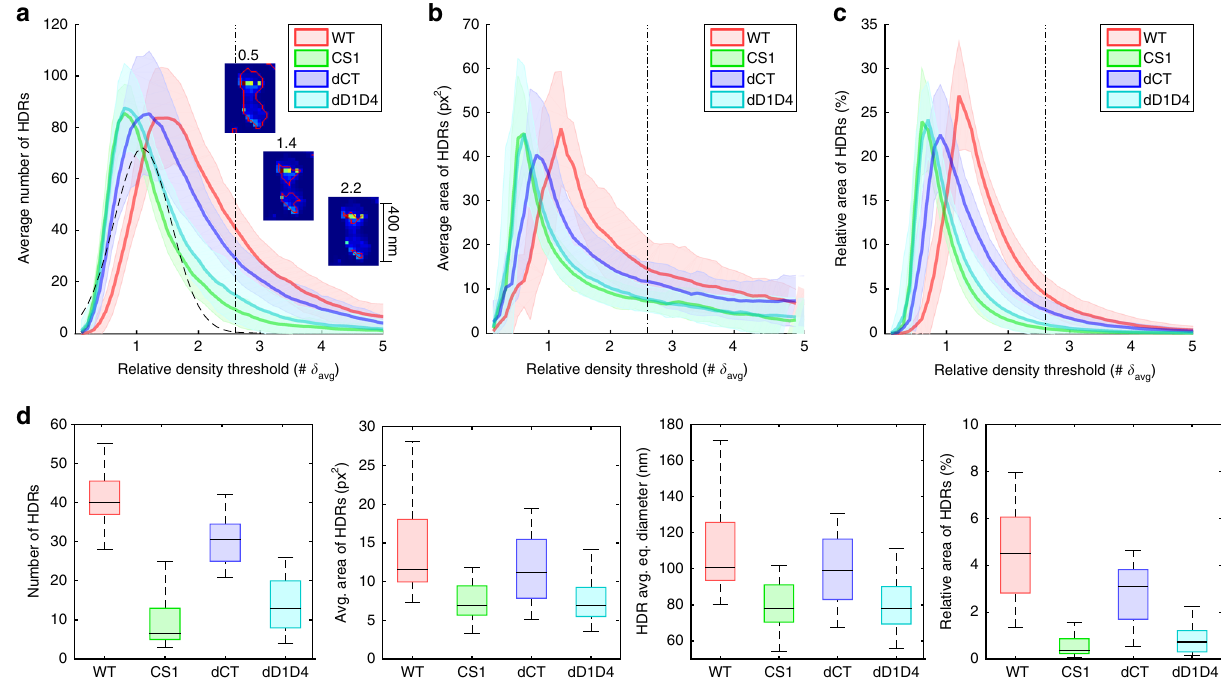
Fig. 3 SOFI analysis of four CD4 protein variants in resting T cells immobilized on poly- L -lysine-coated coverslips. Native CD4 (WT), palmitoylation mutant (CS1) and variants lacking the extracellular (dD1D4) and cytosolic parts (dCT) were tested ( n = 20 per variant). a Number of high-density regions (HDRs) averaged over all samples for each CD4 variant. Density thresholds are related to the mean density calculated over the 3 × 3 µ m ROIs of all samples. The inset images show examples of the segmented HDRs for various thresholds indicated above the image. b HDR area averaged over all samples for each CD4 variant in px 2 , where pixel size is 25 nm. c Relative area occupied by HDRs related to the total area of the ROI. d Box plots of the properties of HDRs for a threshold equal to 2.6 δ avg (marked by the vertical dash dot line). The chosen threshold is the value, where Gaussian function of a random distribution (marked in a by the dashed line) falls below 1 (Supplementary Fig. 2). Semi-transparent color areas in a – c represent standard deviation. In each box plot in d , the box represents the interquartile range (IQR), the central mark is the median, and the whiskers extend to the most extreme data points. Each box plot was calculated over 20 ratios (20 – 100). The accuracy of HDR detection increases with